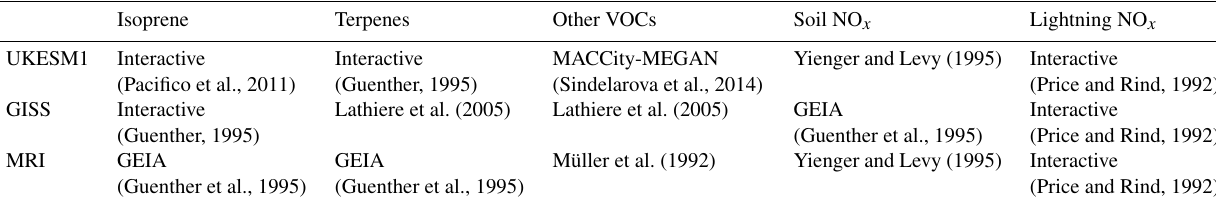
Table 1. Sources of natural emissions of ozone precursors. Where emissions are prescribed, the source is provided. Interactive emissions respond to climate change. Isoprene Terpenes Other VOCs Soil NO x